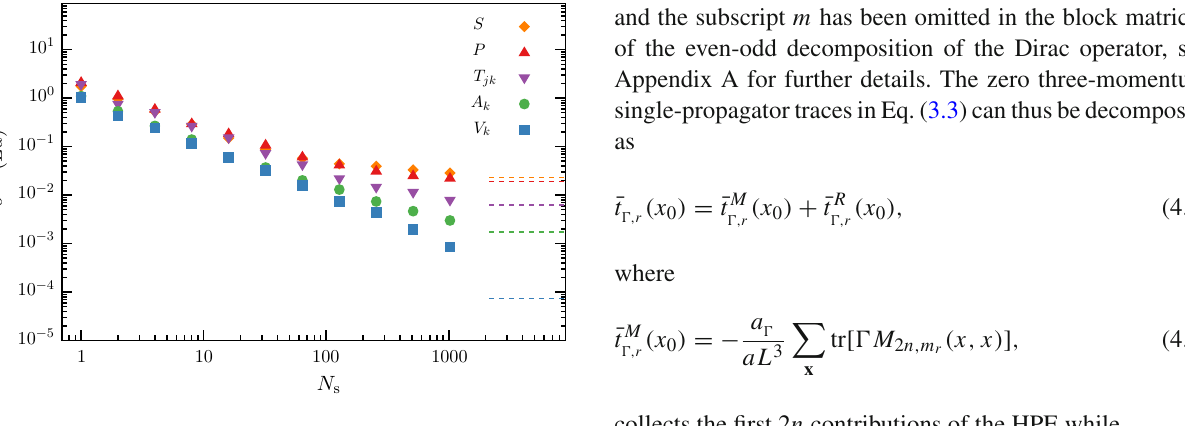
ble F7. Data for the E5 and the G8 lattices show the same qualitative behaviour. Variances go down linearly in 1 / N s until the random-noise contribution becomes negligible, see Eq. (3.11), after which a plateau corresponds to the gauge noise (dashed lines). The first clear message from the data is that the random-noise contribution to the variances is com- parable for the various bilinears, as suggested by Eq. (3.11), and it is orders of magnitude larger than the gauge